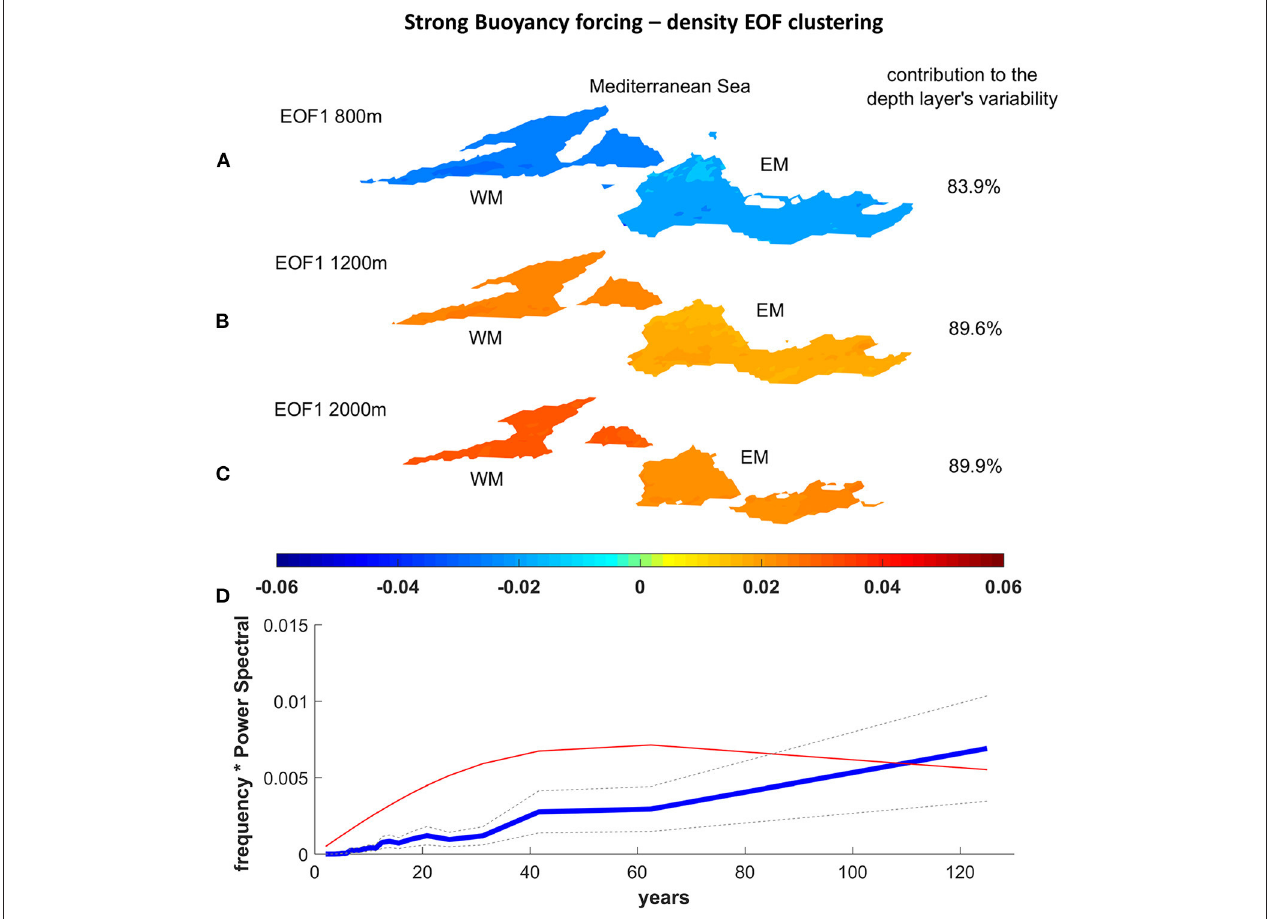
FIGURE 11 | The first EOF modes of 800 (A) , 1,200 (B) , and 2,000m (C) depth of the SBF experiment, whose expansion coefficients are well-correlated. Here, the variance-preserving spectrum of the 2,000m first EOF is presented as (D)